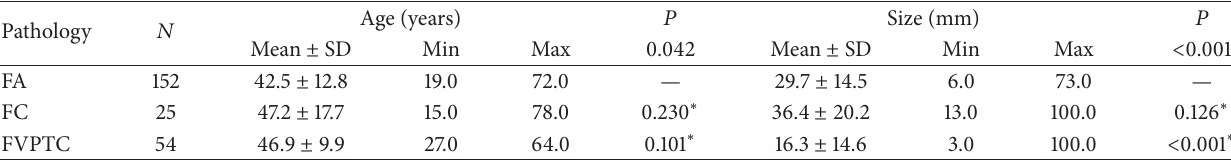
FA: follicular adenoma. FC: follicular carcinoma.